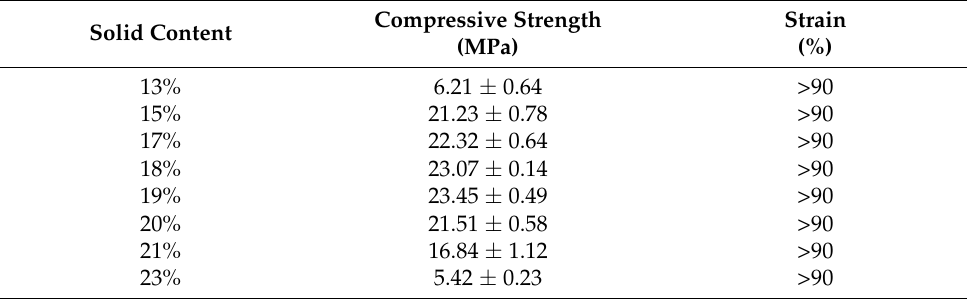
Figure 9. DSC characterization of p–DN hydrogel.